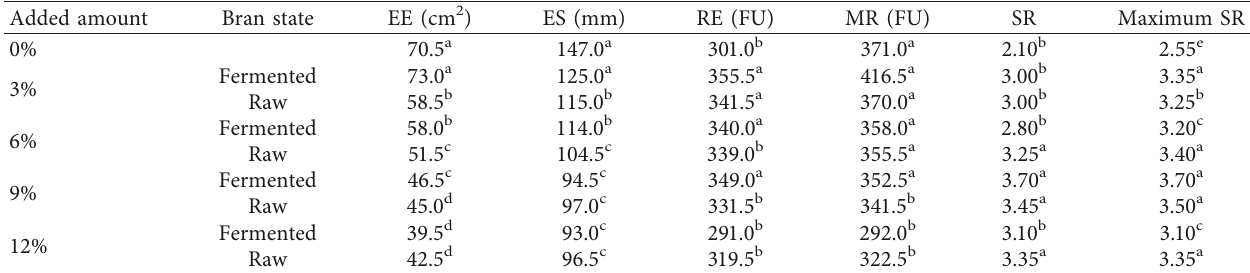
Table 2: Different amounts of added bran and the extensographic properties of the mixed flour. Added